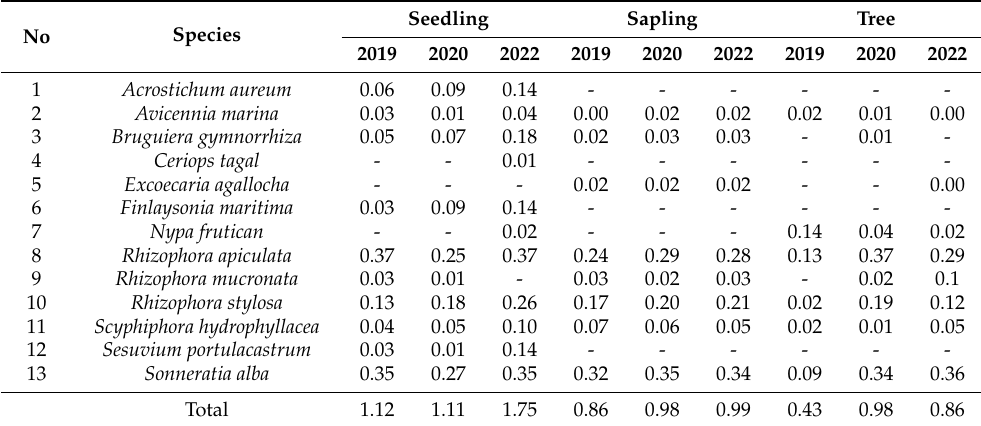
Table 8. Diversity (H (cid:48) ) observed in the restored areas planted with seedling surveyed between 2019–2022.